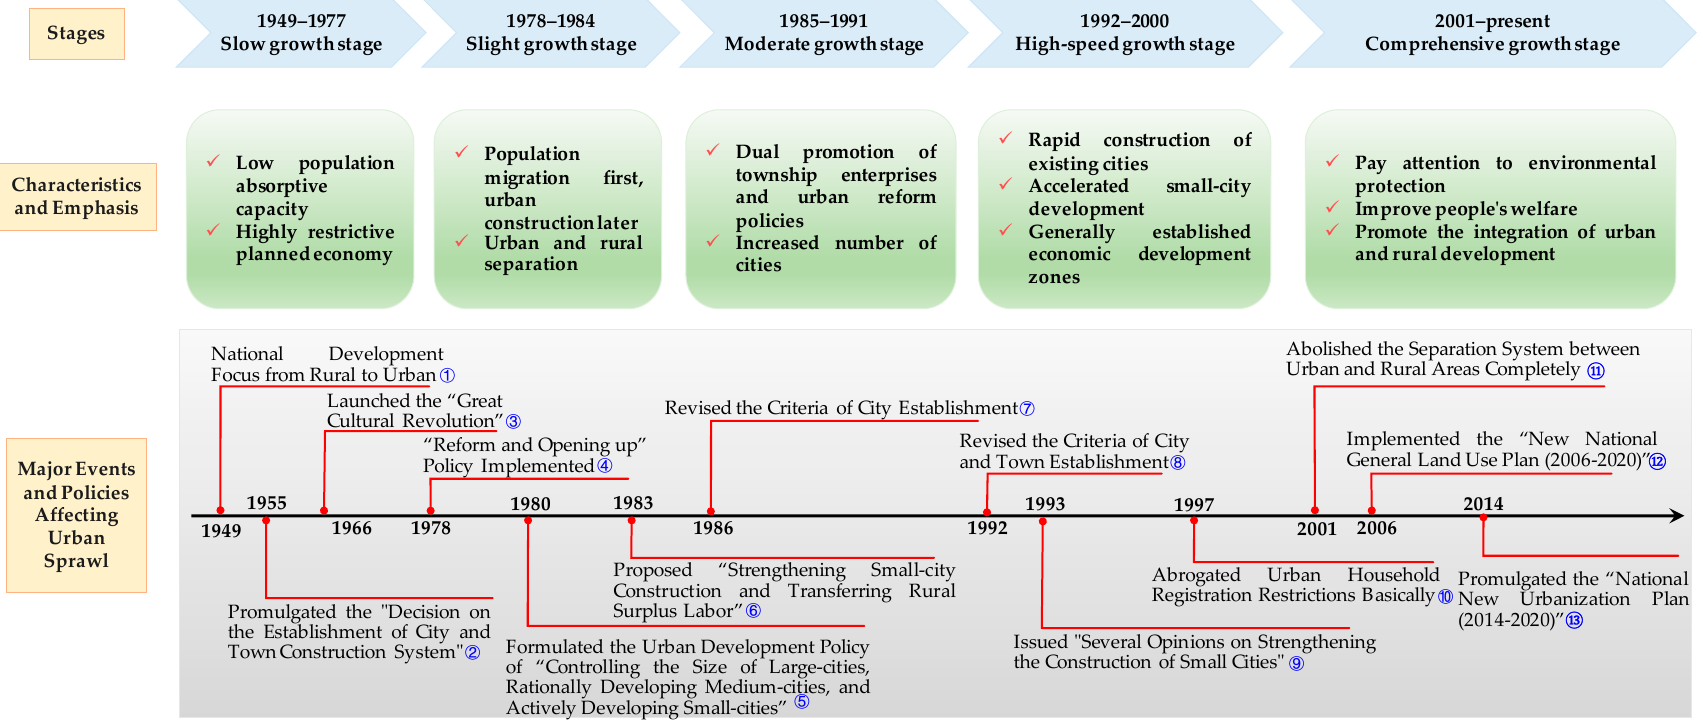
Figure 9. Characteristics, emphasis as well as major events and policies affecting urban sprawl in different stages of China (the major events and policies affecting urban sprawl are referenced by ① [79]; ② [80]; ③ [81]; ④ [63]; ⑤ [62]; ⑥ [82]; ⑦ [83]; ⑧ [84]; ⑨ [85]; ⑩ [71]; ⑪ [75]; ⑫ [72]; ⑬ [86].